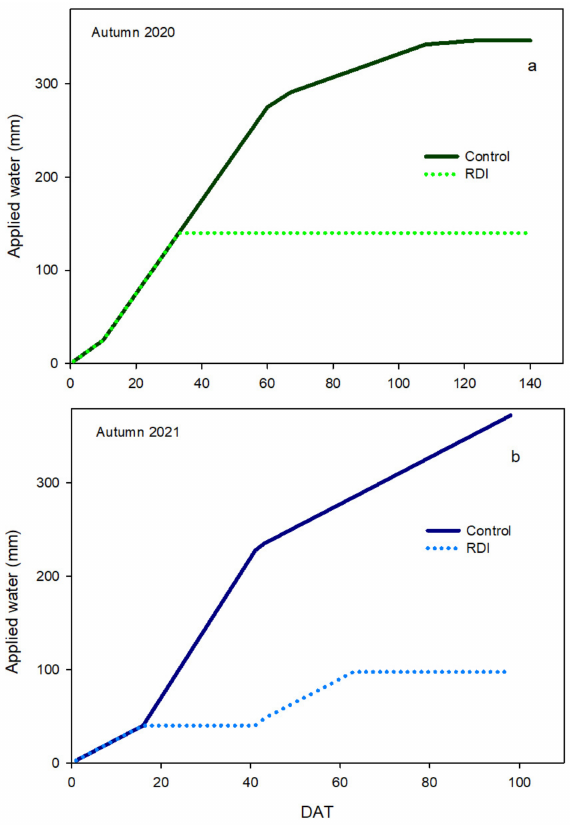
Figure 1. Applied water during the experiment in the 2020 ( a ) and 2021 ( b ) seasons. Solid lines, Control; Dash lines,